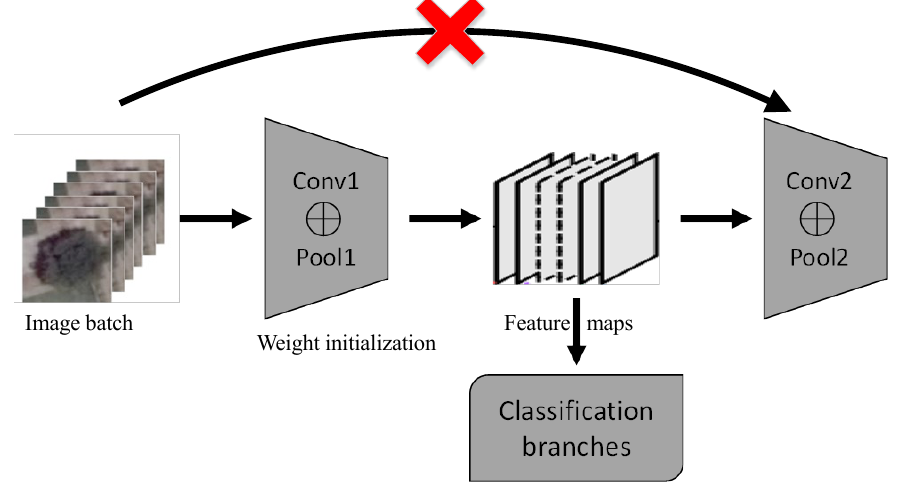
Figure 7. Sharing mechanism of feature